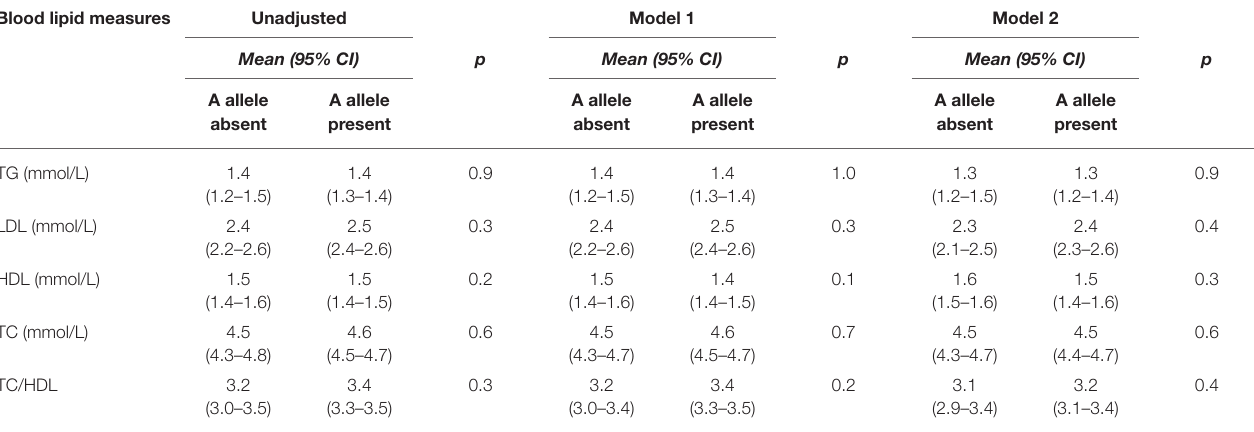
TABLE 7 | Blood lipid measures do not vary by the presence of the KCNJ2 -A allele in unadjusted and adjusted models. Blood lipid measures Unadjusted Model 1 Model 2 Mean (95% CI) p Mean (95% CI) p Mean (95% CI) p A allele A allele A allele A allele A allele A allele absent present absent present absent present